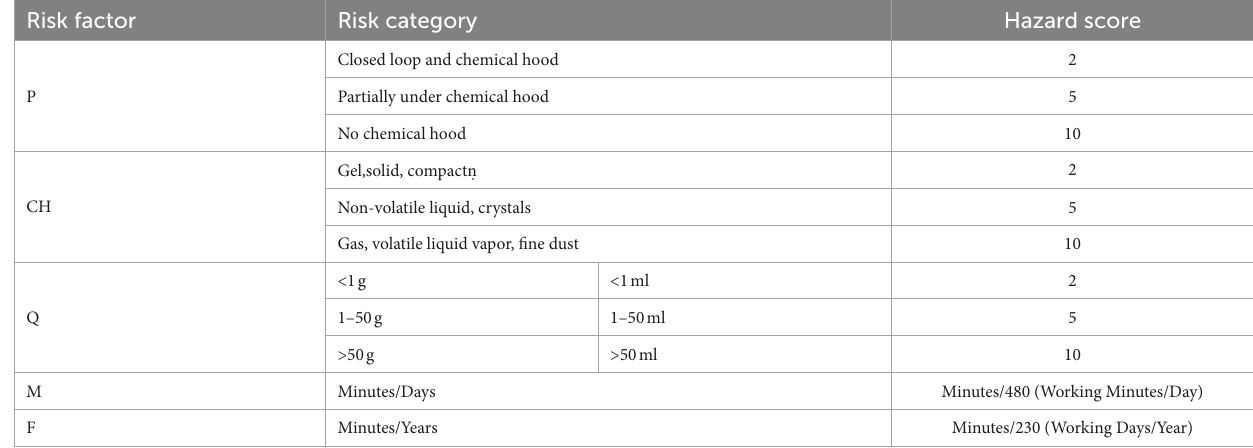
TABLE 1 Hazard score for each risk category.